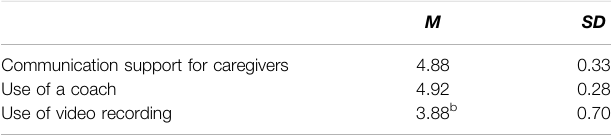
TABLE 3 | Scores on the three items of the Social Validity Scale about the relevance of the intervention a .